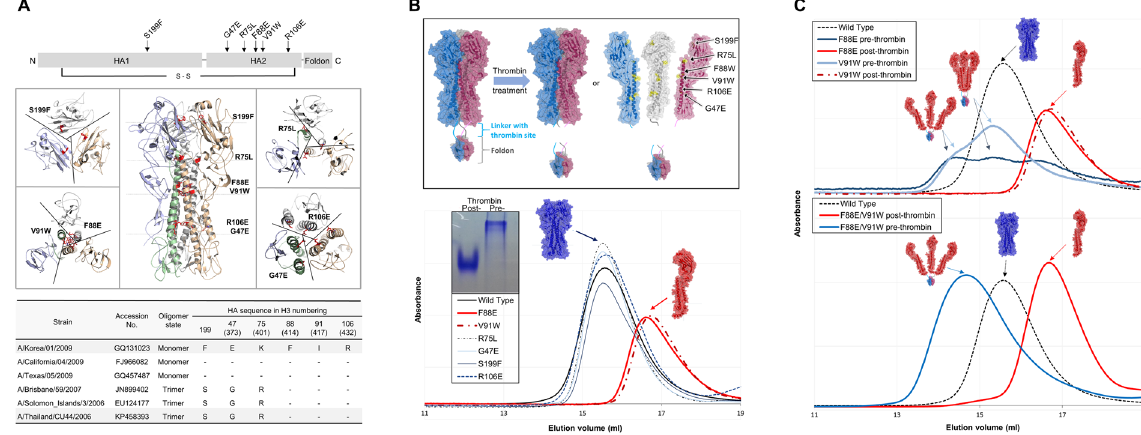
Figure 1. Modulation of the monomer-trimer equilibrium of HA. ( A ) The cloned HA construct with HA1, HA2 and the foldon, showing mutation sites with arrows and a disulfide bond between HA1 and HA2 (upper panel). The mutation sites are highlighted in red on the crystal structure of CU44 HA at the center with cross- section views along the dashed lines at the left (S199F, V91W and F88E) and right (R75K, R106E and G47E) (middle panel). The amino acid sequence differences at the mutation sites among 2009 pH1N1 and seasonal H1N1 HA proteins are shown (lower panel), where the amino acid residue is numbered according to KR01 HA and the corresponding amino acid residue of HA0 is given in parenthesis. The CU44 wild-type HA in this study showed 3 mutations different from the original CU44 HA: HA1 M116I and HA2 I91V and N169S. ( B ) Schematic diagrams showing a modulation of the monomer-trimer equilibrium upon the removal of the foldon by thrombin treatment (upper panel). The equilibrium can depend on mutation at the intermonomer interface. The HA trimer where each monomer is shown in blue, red and gray color is dissociated into monomers, if the mutation at the intermonomer interface induces either electrostatic or steric repulsion to destabilize the trimer. Characterization of HA mutant proteins using site exclusion chromatographic analysis (lower panel). F88E and V91W mutants were eluted as a monomer, whereas other mutants were eluted as the wild-type HA trimer. Native PAGE is shown in inset for the pre- and post-thrombin F88E mutant HA. ( C ) Characterization of the single mutant, F88E and V91W, and the double mutant F88E/V91W using size exclusion chromatography (upper and lower panels, respectively). Single and double mutants without the foldon (post-thrombin) were eluted as monomers. The wild-type HA trimer in blue is shown as a single peak (dashed line).